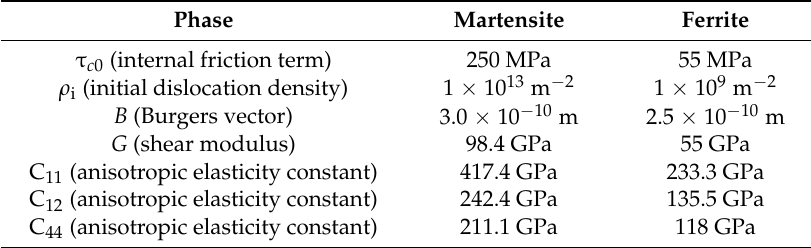
Table 4. The simulated parameters of single crystals.